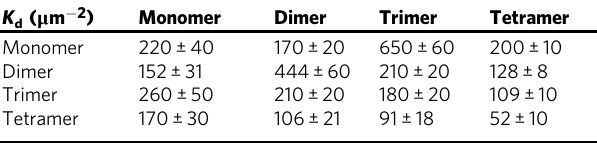
Table 1 K d values arranged in a matrix where each molecular species arises from the sum of the components